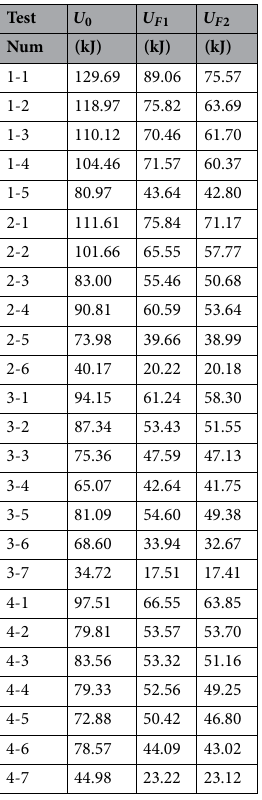
Table 10. The calculated internal energies U (kJ), solved with Eq. (4), adjusting for mixed liquid–vapor, using the internals energies U (kJ) tabulated in Table 9, with the qualities X tabulated in Table 8, solved with Eq.